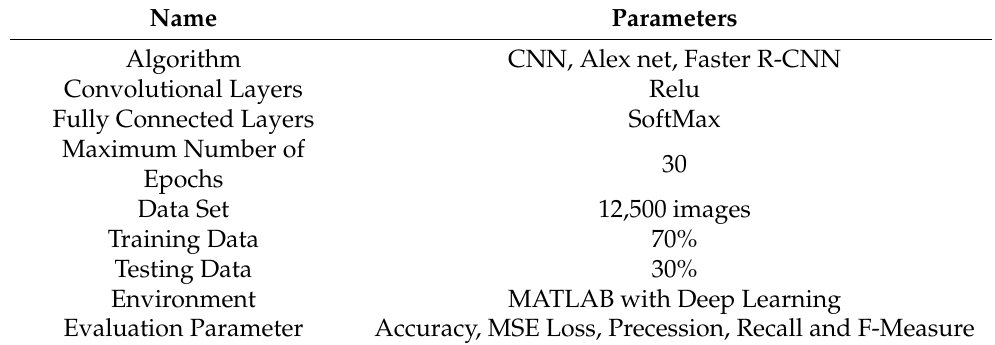
Table 5. Parameters detail.